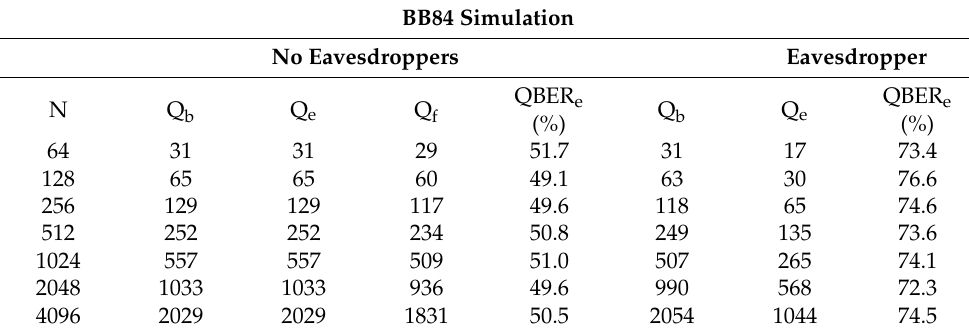
Table 8. BB84 simulation test data.